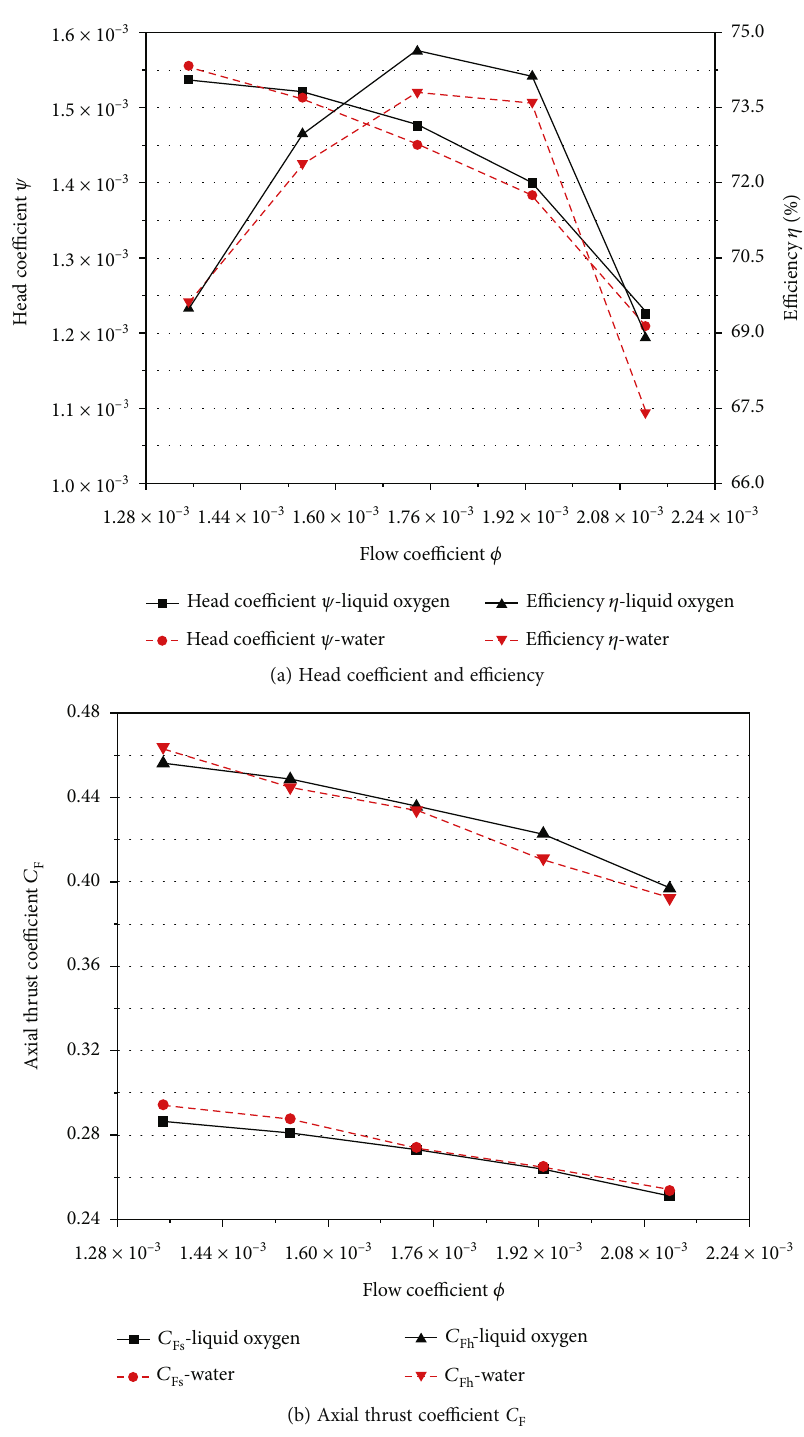
Figure 10: Comparison of the performance under di ff erent